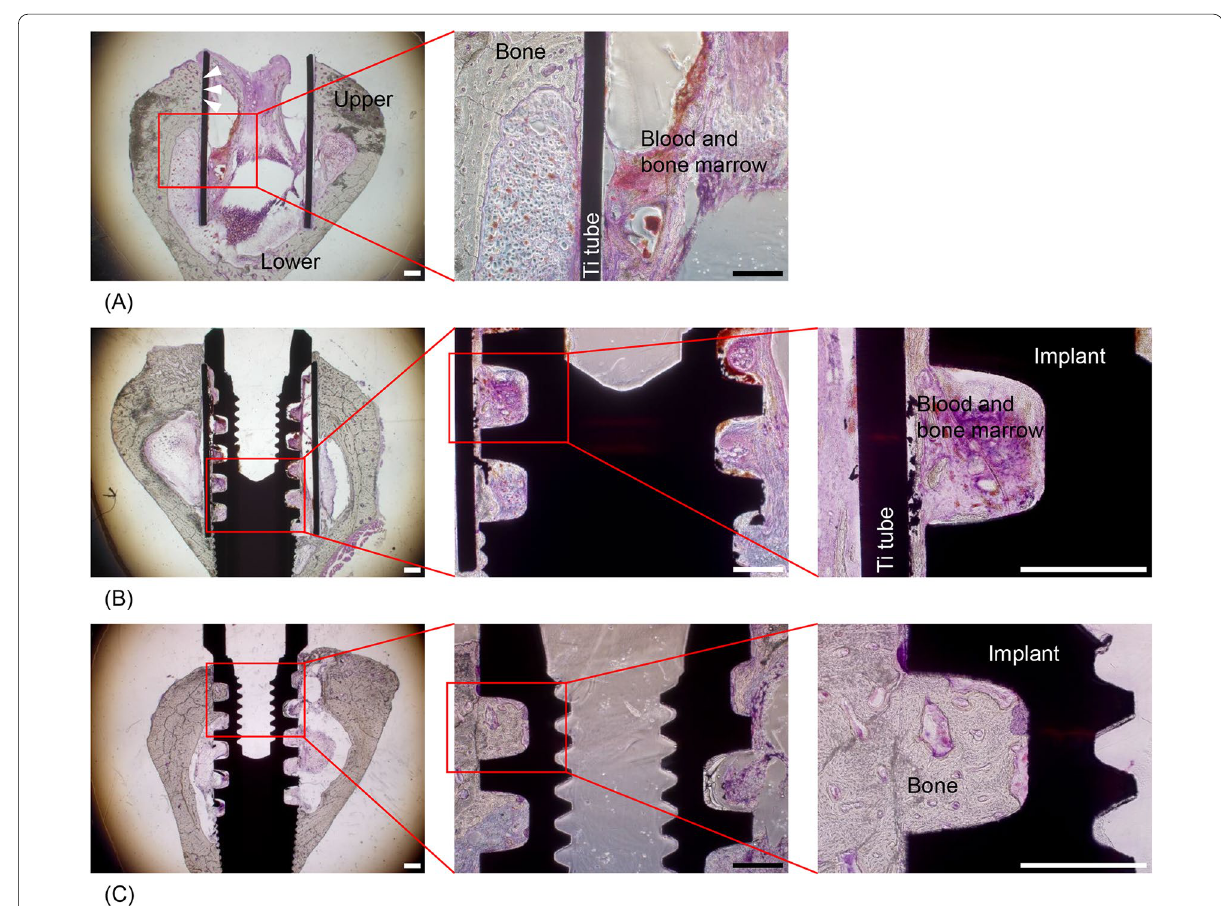
Fig. 4 Representative histological images (haematoxylin and eosin staining) of bone formation around the SLA Ti implants and the turned Ti tubes. A Ti tube‑only condition. Normal bone (grey stain) healing on the turned outer surface is shown (white arrowheads). Inside the tube, however, little bone formation was observed, even 4 weeks after implant insertion into the rabbit tibia. B Ti tube was observed between the Ti tube and the Ti implant. Most of the area between the tube and the implant was filled with blood and bone marrow (purple stain). C With no Ti tube (implant‑only condition), normal bone formation was observed around the SLA Ti implants. Scale bars